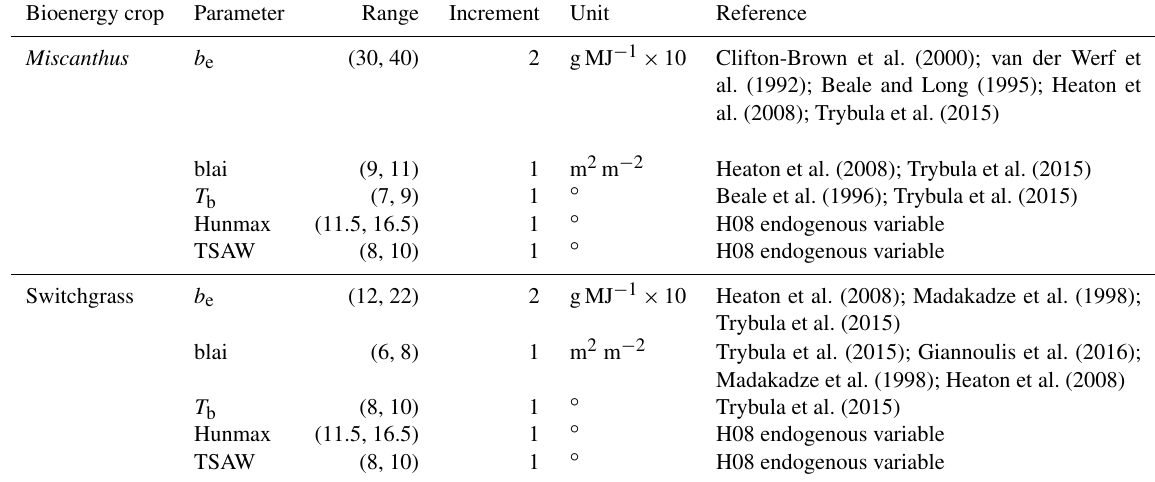
Table 3. Parameter ranges for the calibration simulations. Bioenergy